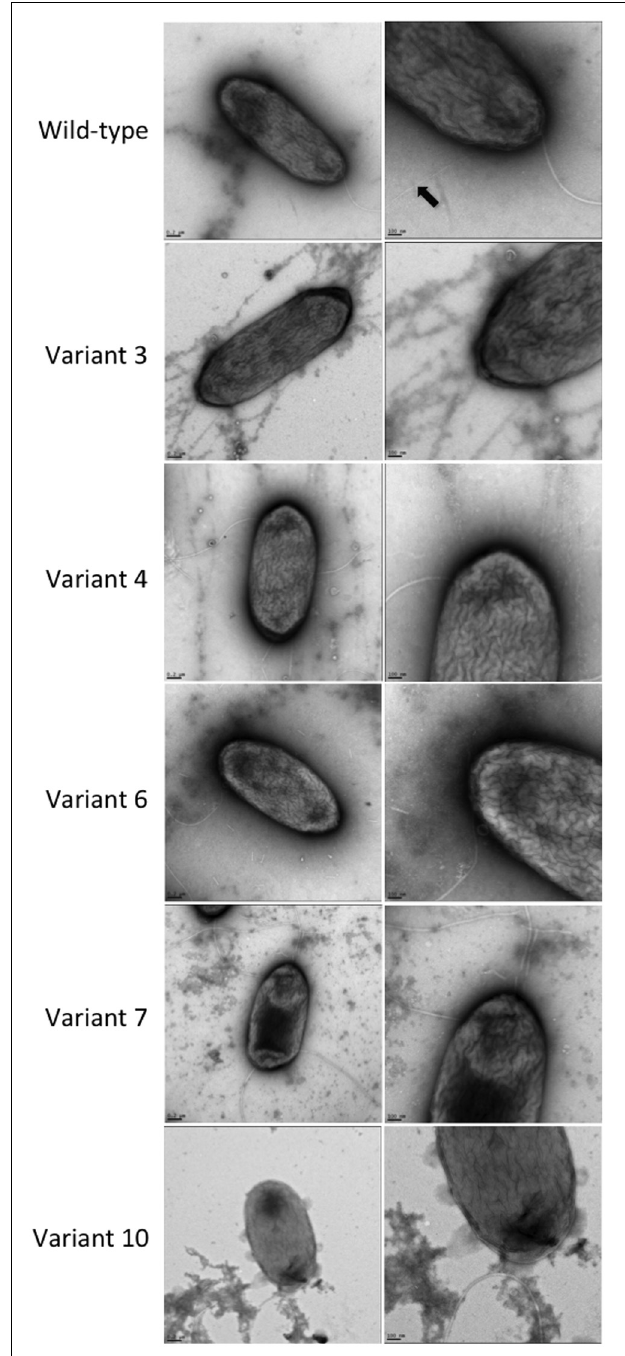
FIGURE 5 | TEM observation of the P. aeruginosa PAO1 wild-type and five phage-resistant variant strains. A black arrow indicates the pili in the wild-type strain.